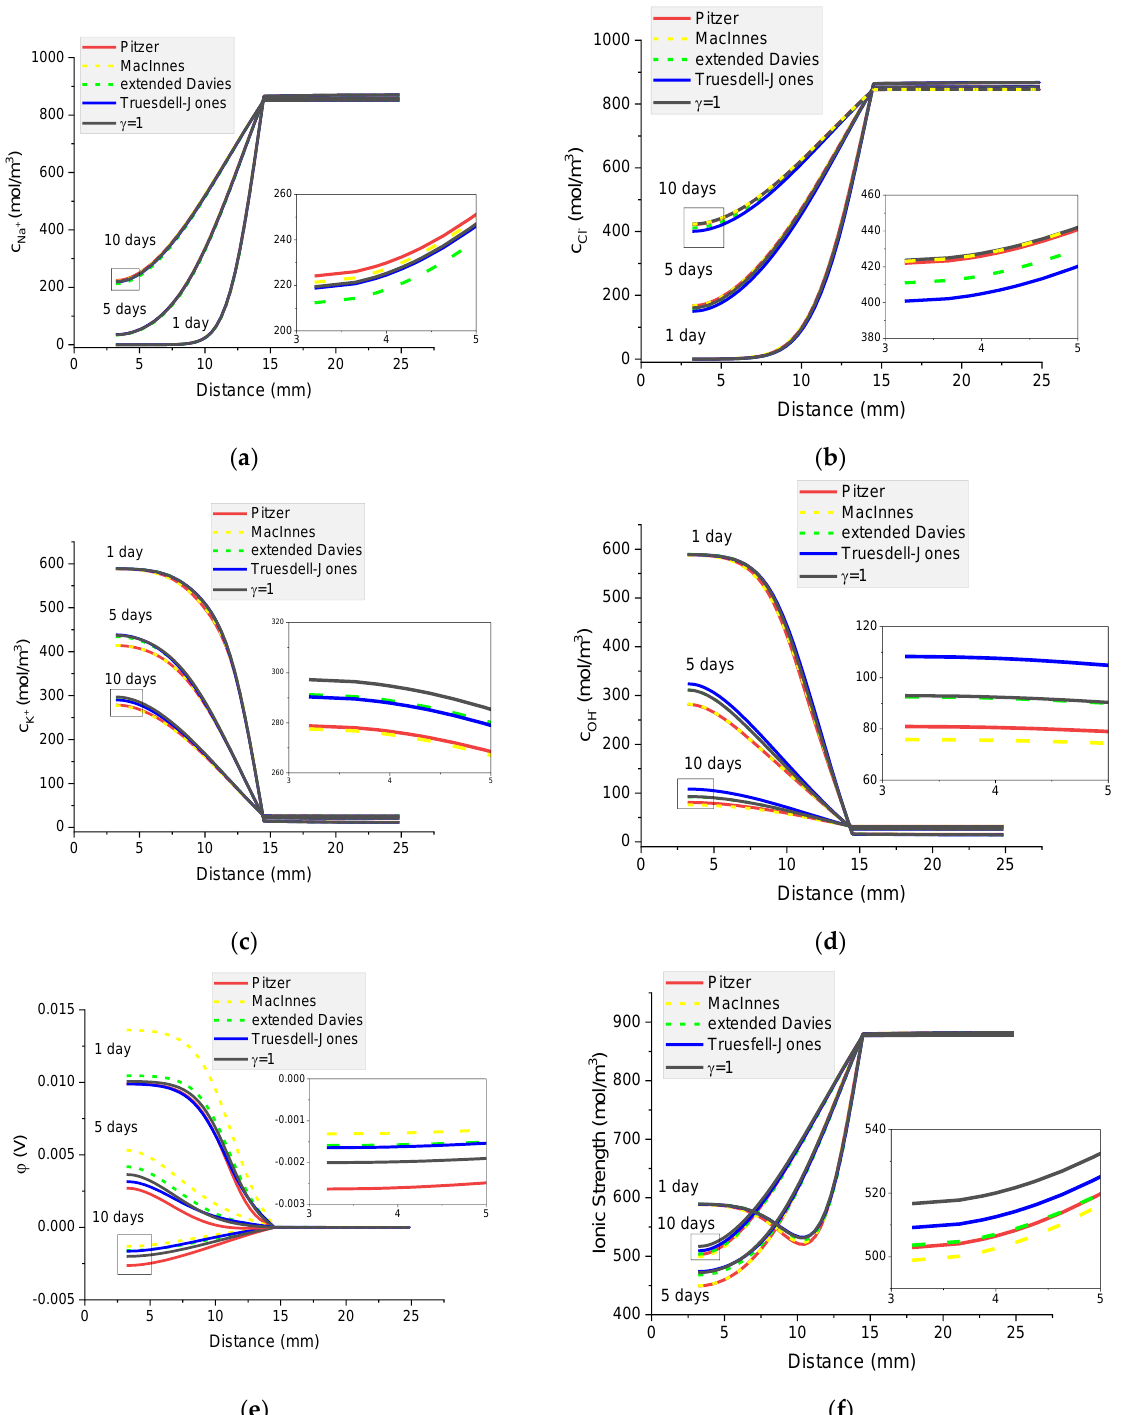
Figure 16. Calculated concentration profiles of ions in the mortar immersed in 5 wt% NaCl water solution. ( a ) Na + ; ( b ) Cl − ; ( c ) K + ; ( d ) OH − ; electrical potential ( e ) and ionic strength ( f ) after 1, 5, and 10 days.